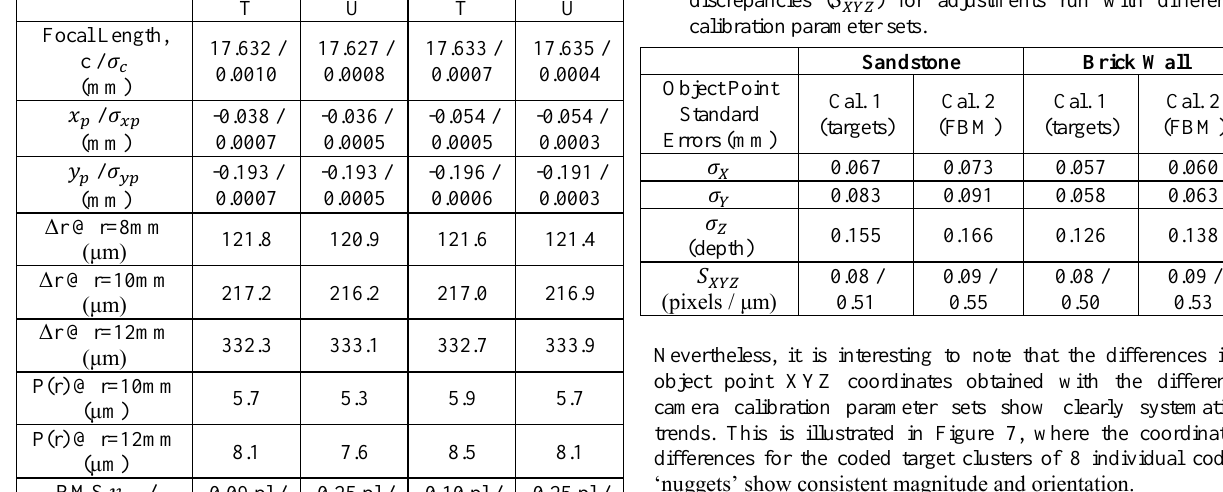
Table 2. Object point precision (  ) and RMS coordinate discrepancies (